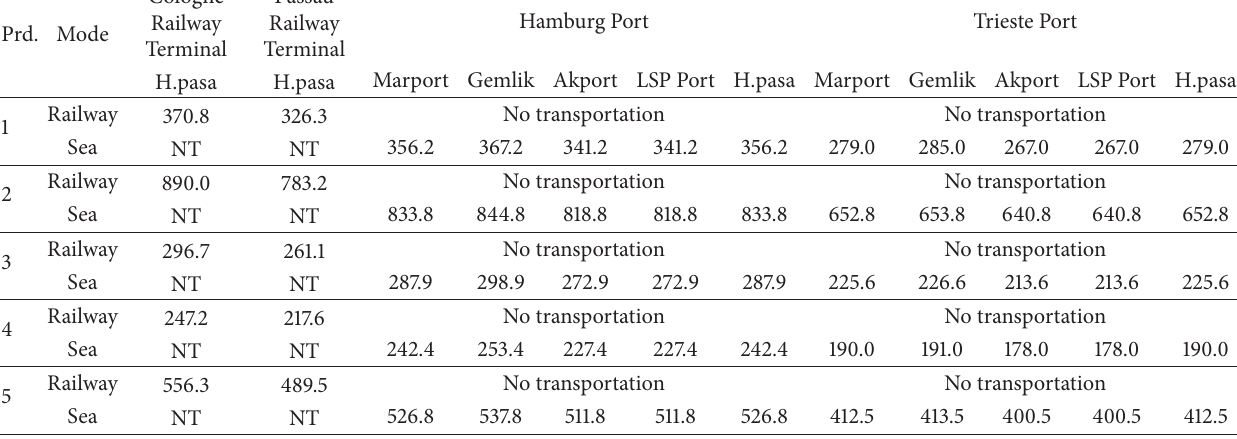
Table 5: Transportation costs from the first to the second transshipment terminals (TL/unit product).